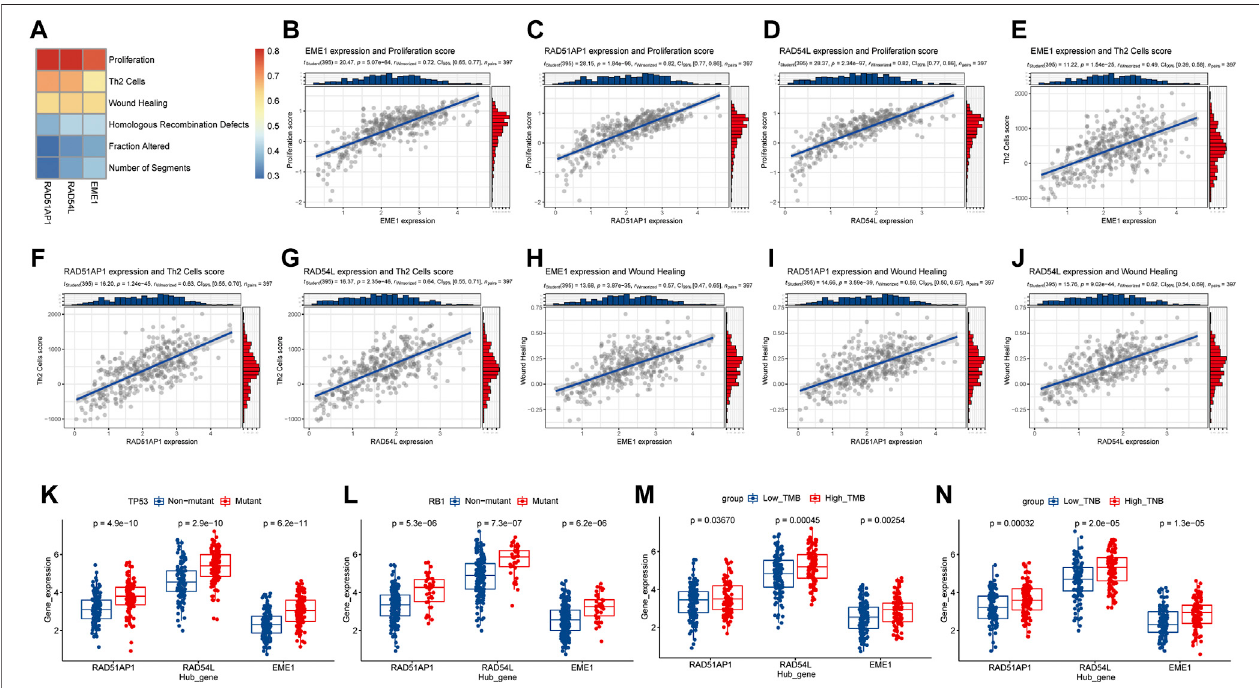
FIGURE10| AnalysisoftherelationshipbetweenhubgenesinHRandtumorprogressionandgenemutation. (A) ,Heatmapofcorrelationbetweenhubgenesand signature scores of core biological functions; (B – J) , Correlation diagram between hub gene and the signature scores of core biological functions with moderate correlation; (K,L) , Hub gene expression levels in TP53, RB1 gene mutation, and non-mutation samples distribution. (M,N) , Distribution of hub gene expression levels in high and low TMB and TNB samples. HR, homologous recombination; TMB, Tumor mutation burden; TNB, tumor neoantigen